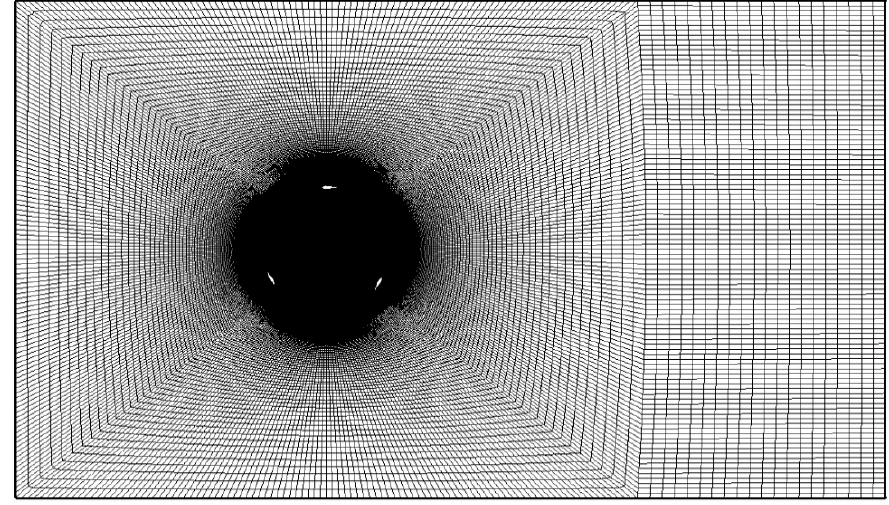
Figure 6. Global mesh of computational domain.